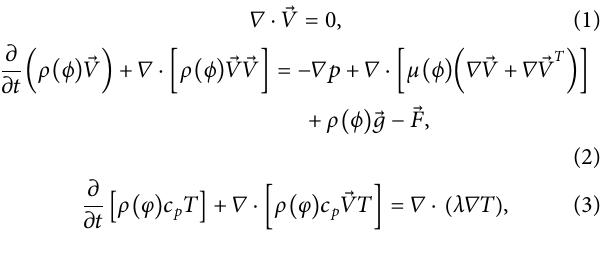
Frontiers in Energy Research |